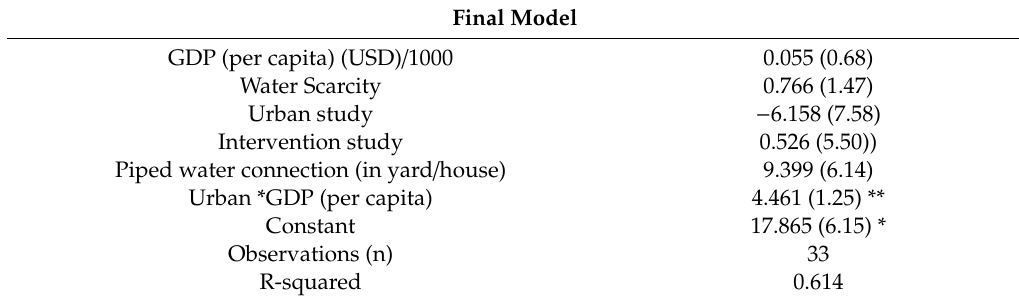
Table 5. Multiple linear regression model of reported litres / capita / day (LPCD) from dominant household supplies across Africa, based on a subset of studies published between 2000 and